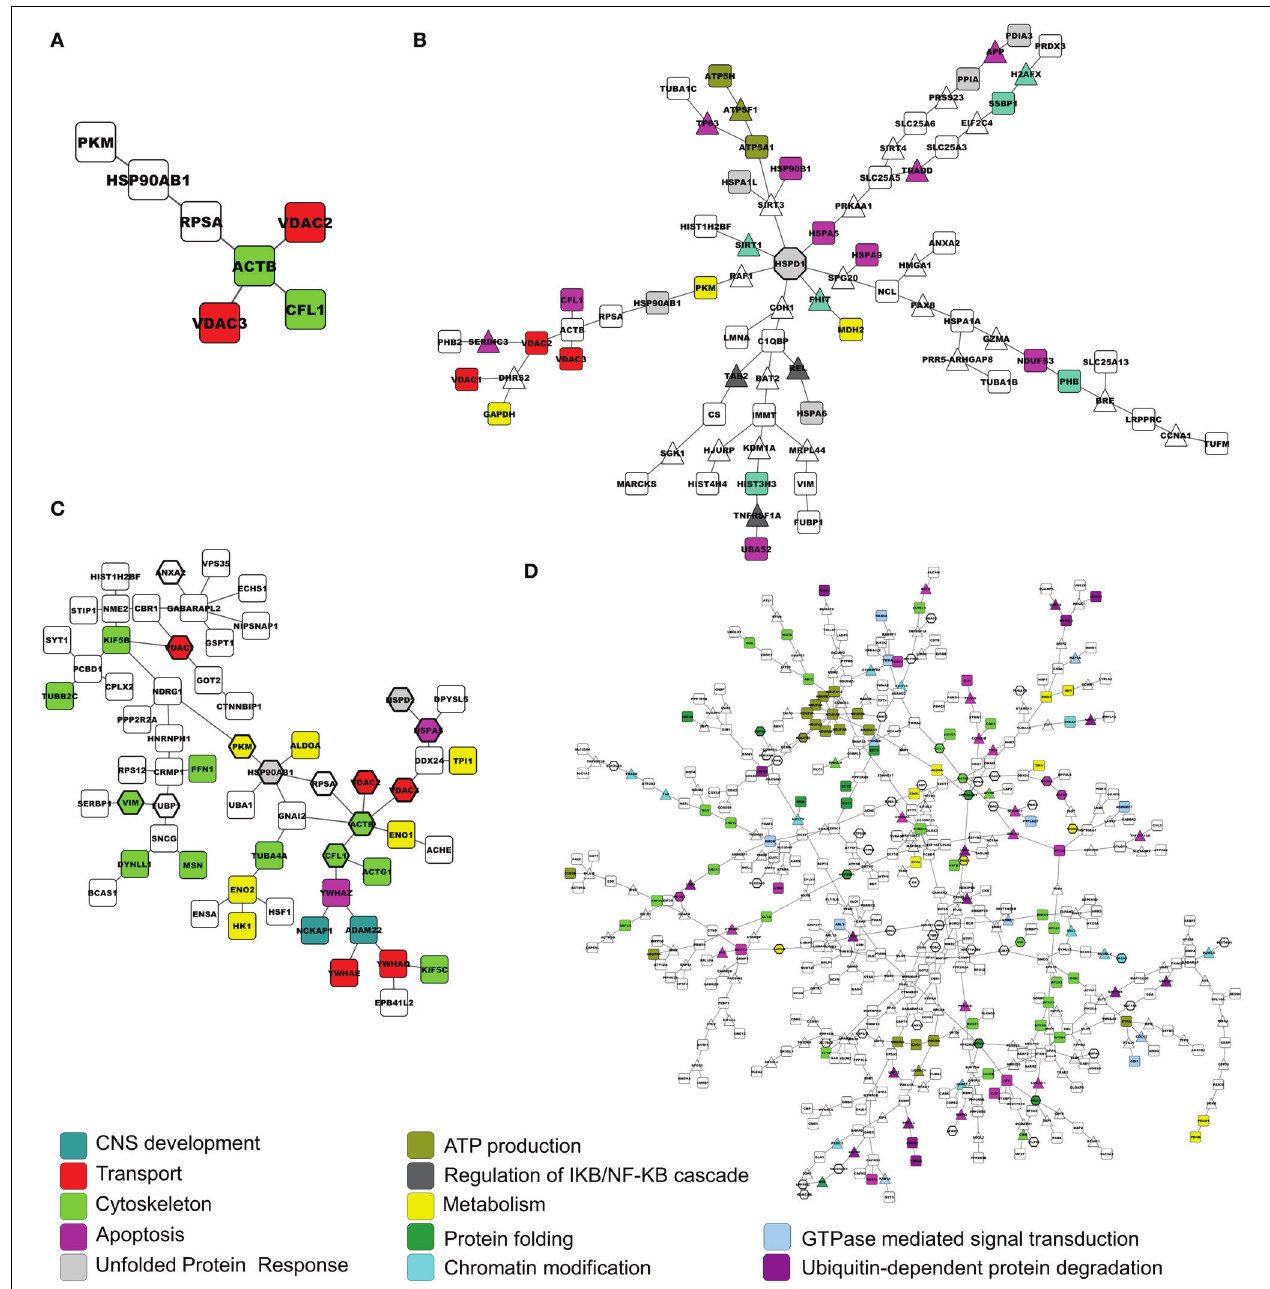
FIGURE 2 | Networks built by PPIspider, using the IntAct database as the reference set. (A) D1 model of the EXP list. (B) D2 model of the EXP list. (C) D1 model of the META list. (D) D2 model of the META list. Proteins from the input lists are represented by